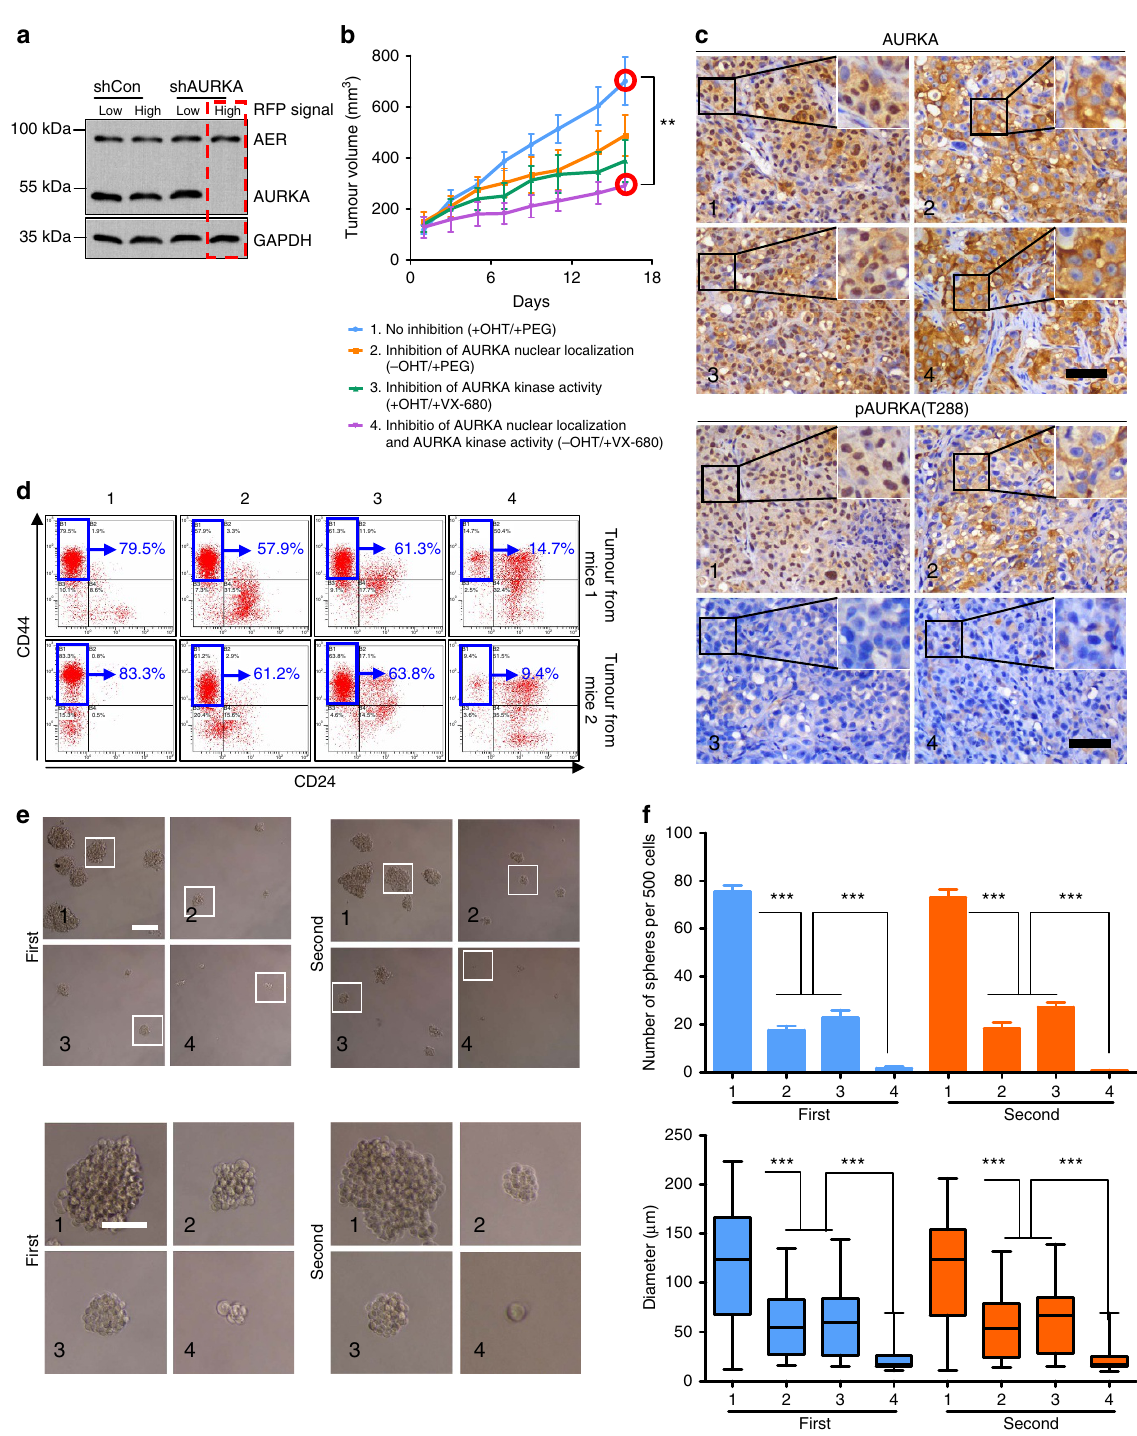
Figure 6 | Blocking AURKA nuclear translocation enhances the anticancer effects of Aurora kinase inhibitor. ( a ) MDA-MB-231 cells expressing AURKA-ER were infected with lentiviral expressing AURKA shRNA or control. The cells were sorted for RFP ( þ ) and the lysates were examined via immunoblotting (IB). ( b ) MDA-MB-231 cells sorted from a (red rectangle) were inoculated subcutaneously in nude mice. Mice treated with OHTwere then administered the indicated treatments via intraperitoneal injection. Data were presented as the means ± s.e.m.; n ¼ 5 per group. The statistical significance between tumour volumes was calculated using one-way analysis of variance (ANOVA) with Dunnett’s multiple comparison tests (group1 versus group4). See also Supplementary Methods. ( c ) IHC staining was performed on tumours harvested at the end of the animal experiment ( b ). Scale bar, 100 m m. ( d ) Flow cytometry for the expression of CD44 and CD24 on single cells from tumour xenografts. ( e ) Mammosphere formation by single-cell suspensions derived from tumour xenografts (left panel). The mammosphere were used to perform a secondary passage (right panel). ( f ) Quantification of the diameters of the spheres from e . The upper panel shows the number of F4 60 m m mammospheres. Statistical comparison was performed (lower panel) using the Kruskal–Wallis test followed by Dunn’s multiple comparison test (*** P o 0.001). Data are presented as the means ± s.e.m. of three independent experiments (analysis of variance (ANOVA) followed by least significant difference (LSD) test; * P o 0.05; ** P o 0.01; *** P o